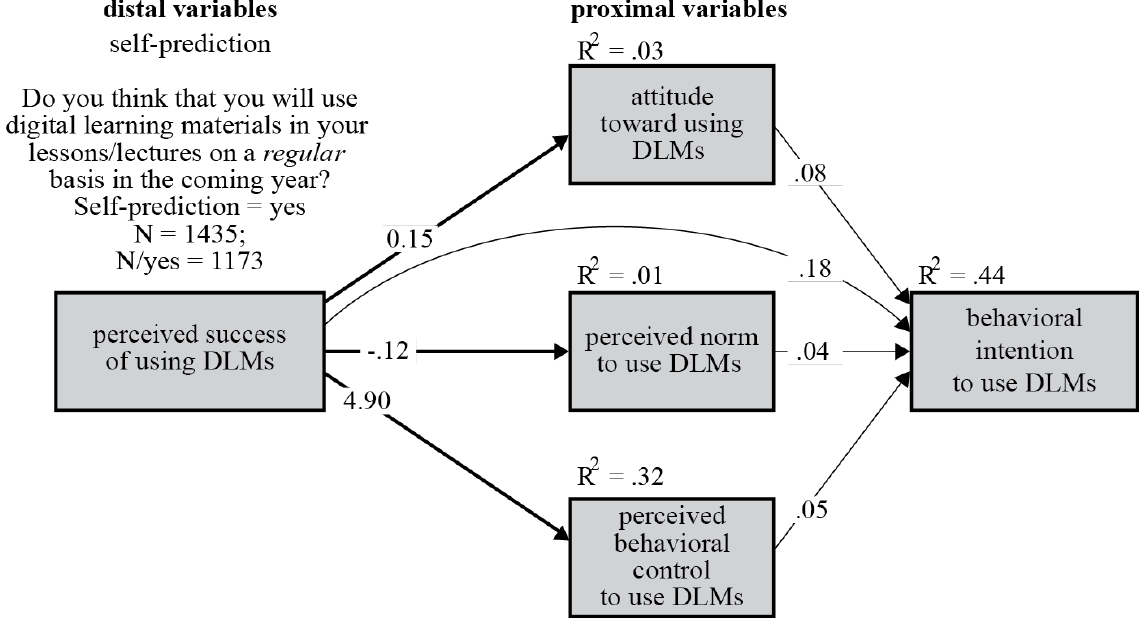
Figure 3a . Results of the mediation analysis of the model for the case that self-prediction = “yes.” The displayed (unstandardized) path coefficients are significant at p <.001 level. Non-significant paths are shown grey in the figure. Thick black lines reflect the indirect effect of the distal variable via the three